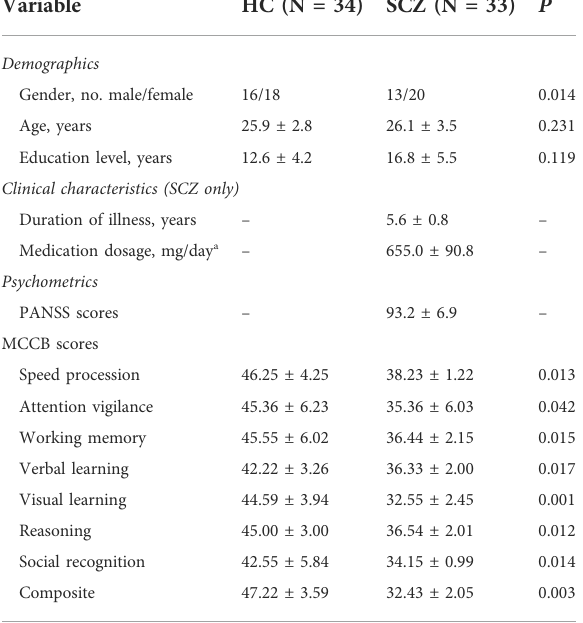
TABLE 1 Reporting and comparison of demographics, clinical characteristics, and psychometric variables across schizophrenia (SCZ) and healthy control (HC) groups.